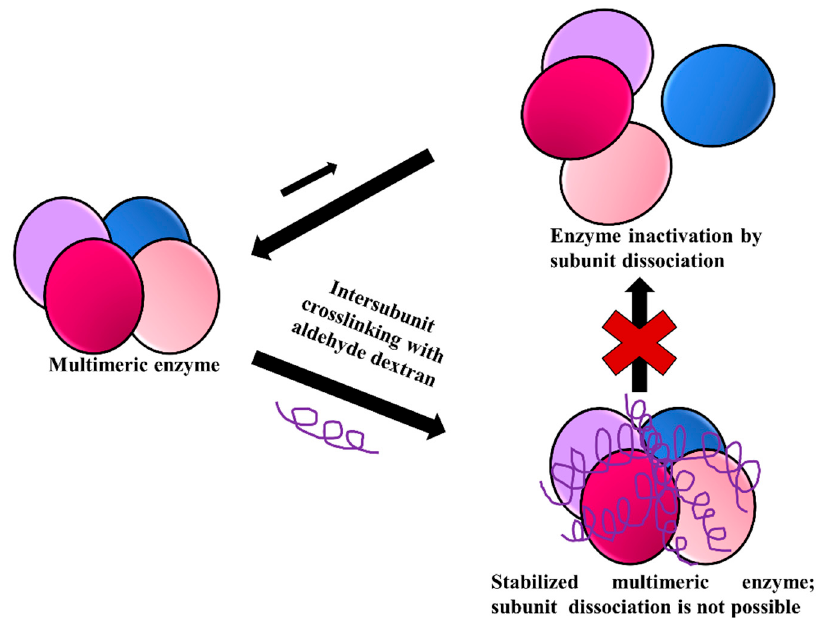
Figure 17. Stabilization of multimeric enzymes by intersubunit crosslinking using dexOx.